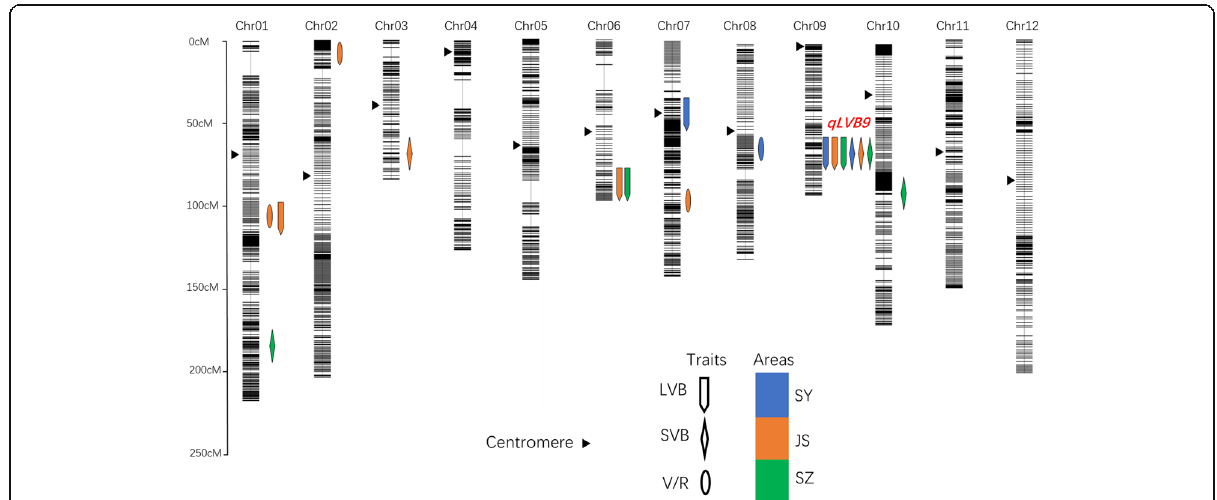
Fig. 2 QTL analysis of vascular bundle traits based on high-density bin maps derived from the RIL population. The scale for the genetic length of each chromosome is shown on the left. The different colors indicate the QTLs detected in the different